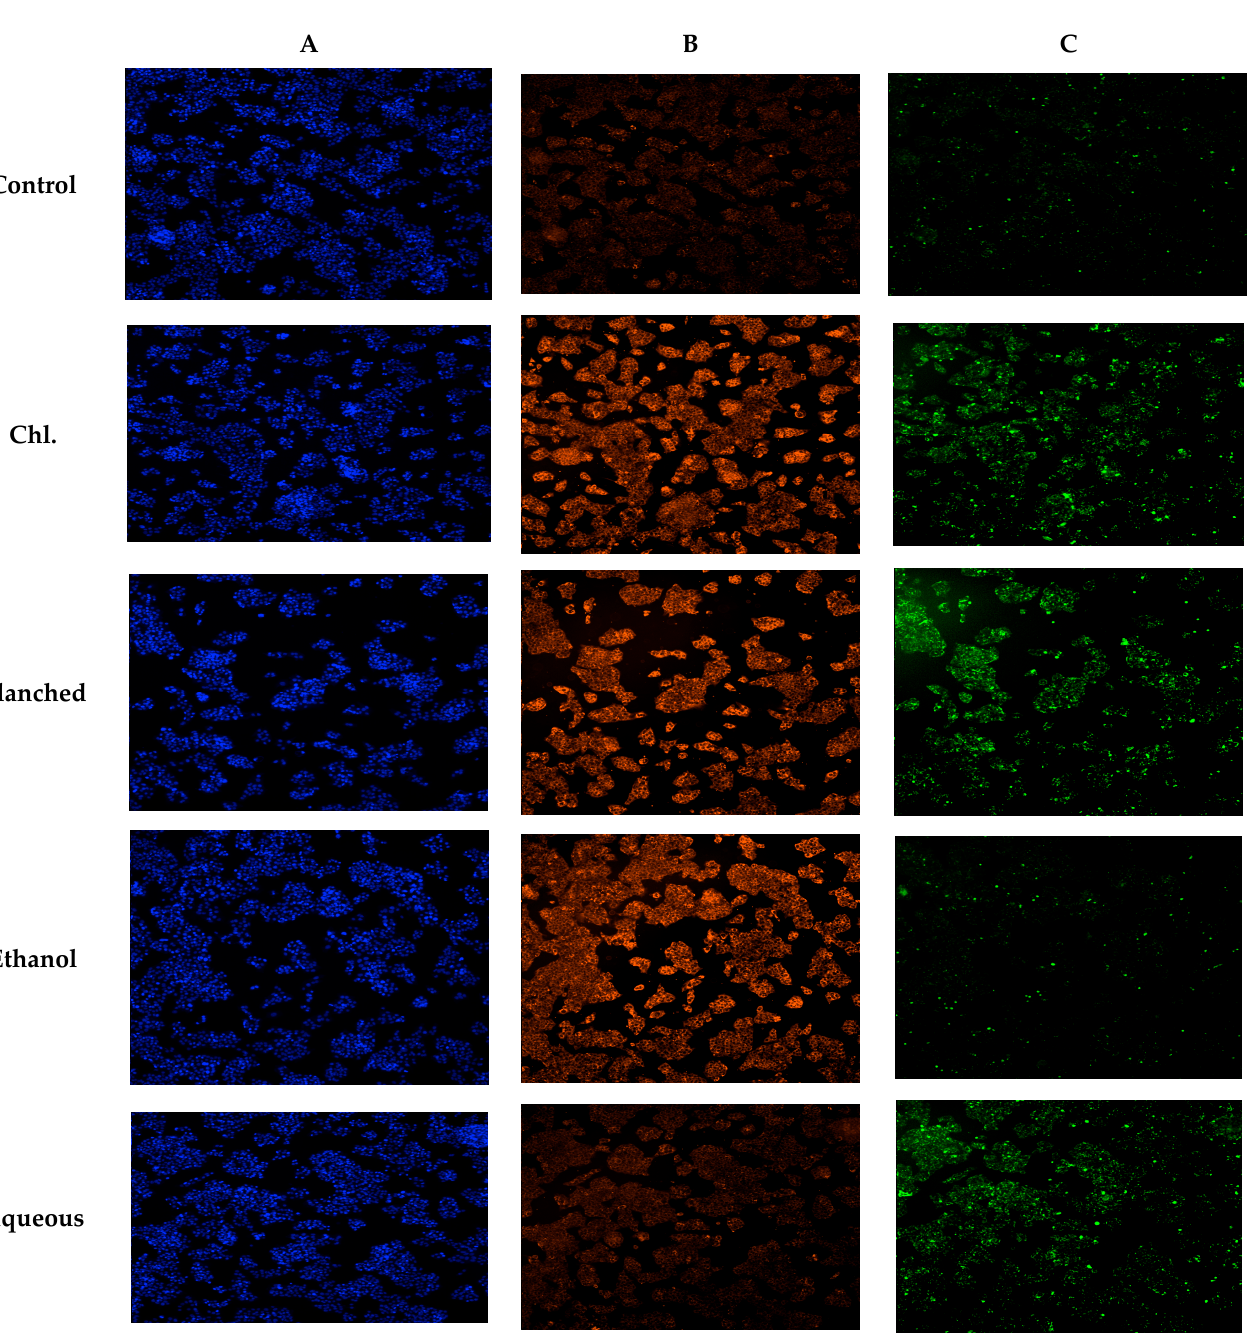
Figure 9. Images of C3A cells after 48 h treatment with 100 µg/mL each of ethanol, blanched and aqueous extracts of H. arborescens leaves obtained from Hoechst 33,342 staining. Column A—All nuclei, Column B—LipidTox Red (neutral lipids), Column C—LipidTox Green (phospholipids).